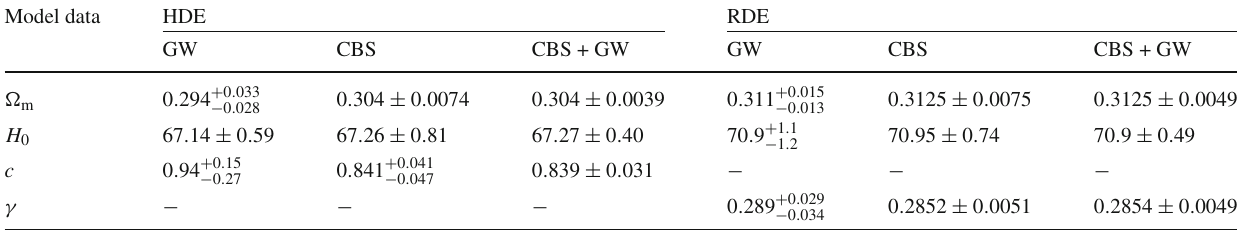
Table 2 Fitting results (68.3% confidence level) for the HDE model and the RDE model using GW, CBS, and CBS + GW. Here, CBS stands for CMB + BAO + SN; H 0 is in units of km s − 1 Mpc −